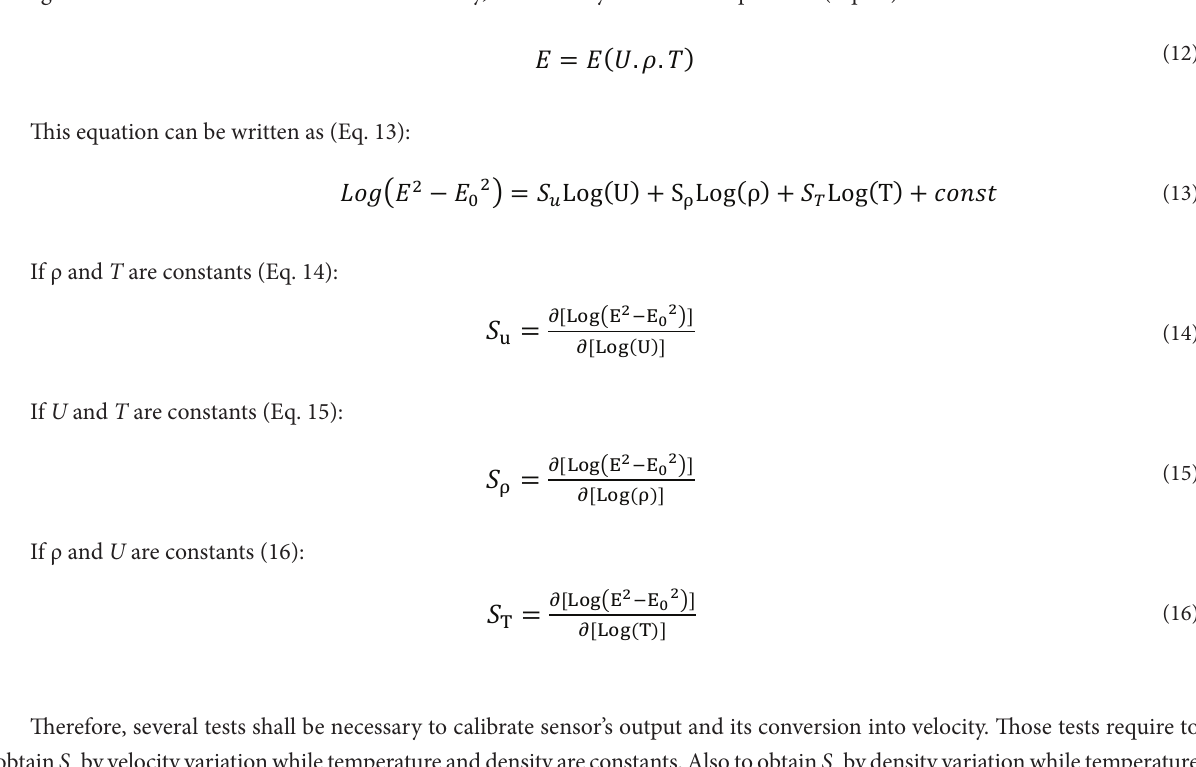
Figure 19. Coefficient of linear correlation between sensors S7 and S14. Analysis of results from Figs. 13 to 19 confirms that the study of wake is possible by means of sensor voltage analysis even for oscillating airfoil. Velocity